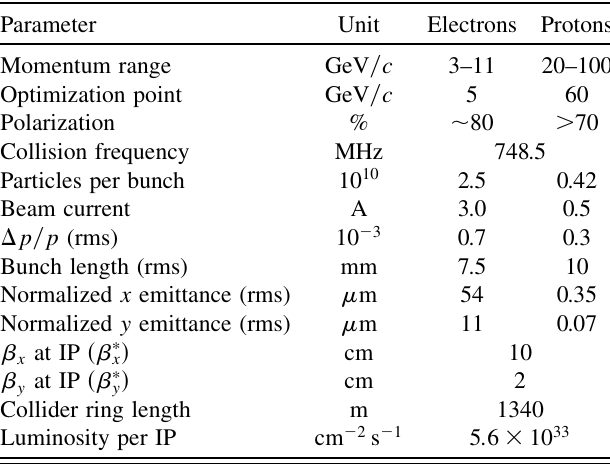
TABLE II. Main MEIC